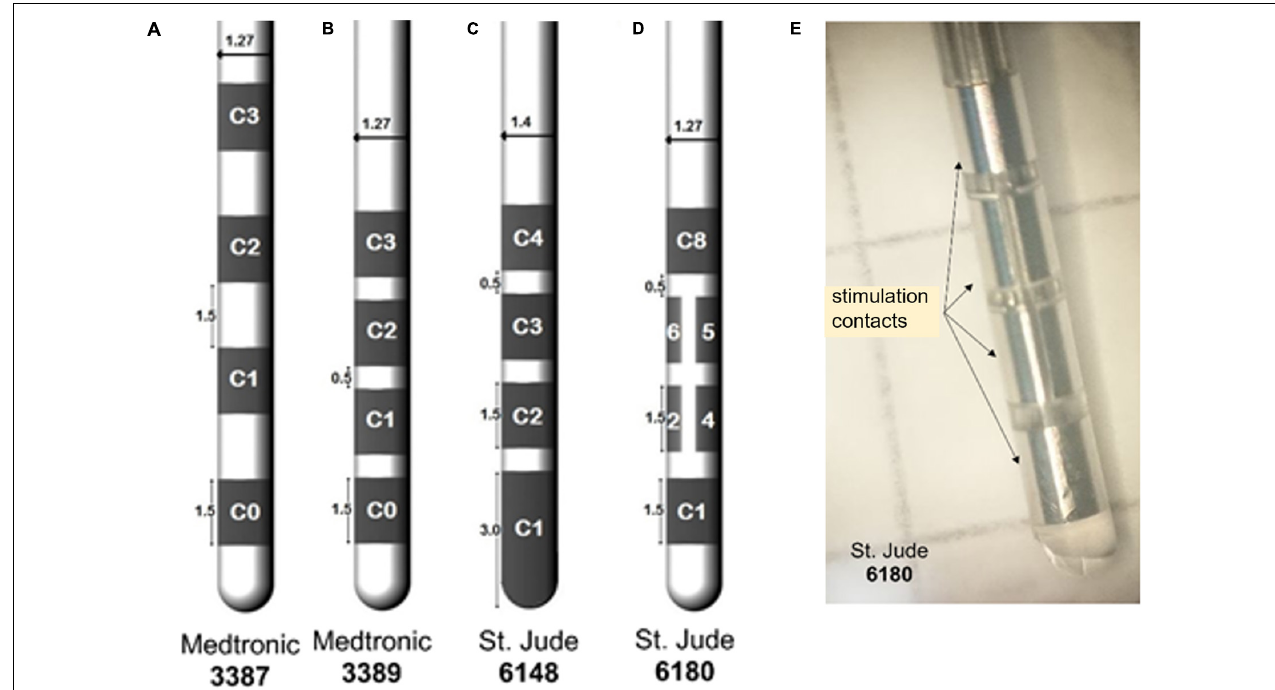
FIGURE 1 | Example of deep brain stimulation (DBS) leads with four contacts and different spacing between the contacts (A) 3387, (B) 3389, (C) tip contact 6148, and (D) with segmented ring contact 6180. The numbering of the contacts differs between companies. (E) A photo of 6180 with marked stimulation contacts. (Alonso, 2018 with